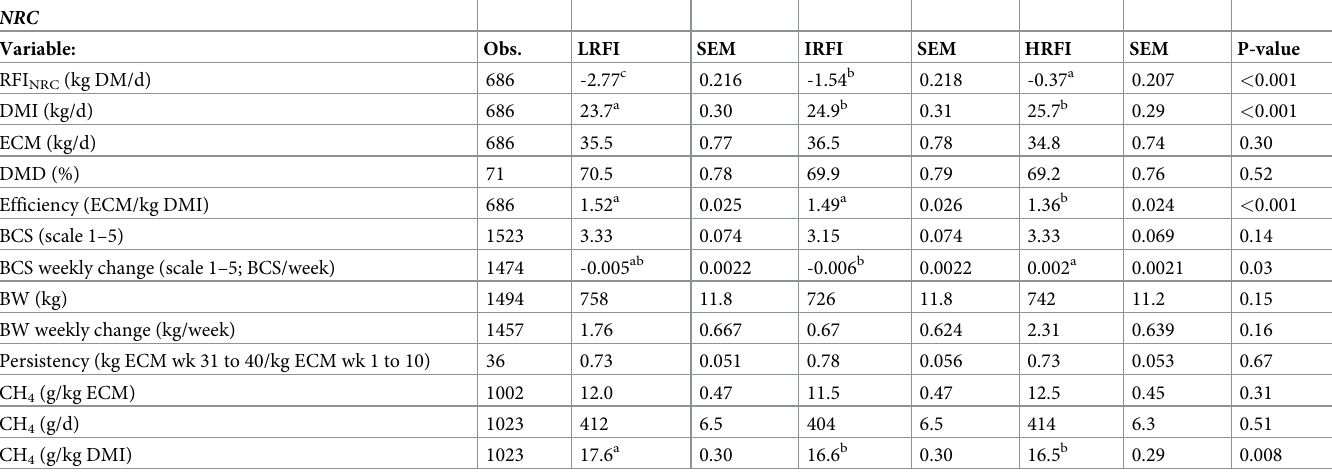
Table 5. Full-lactation performance (mean and SEM) of cows divided into two groups, with low residual feed intake (LRFI) (n = 18) or high RFI (HRFI) (n = 18) according the NRC (2001) equation (for parameter abbreviations, see main text). NRC Variable: